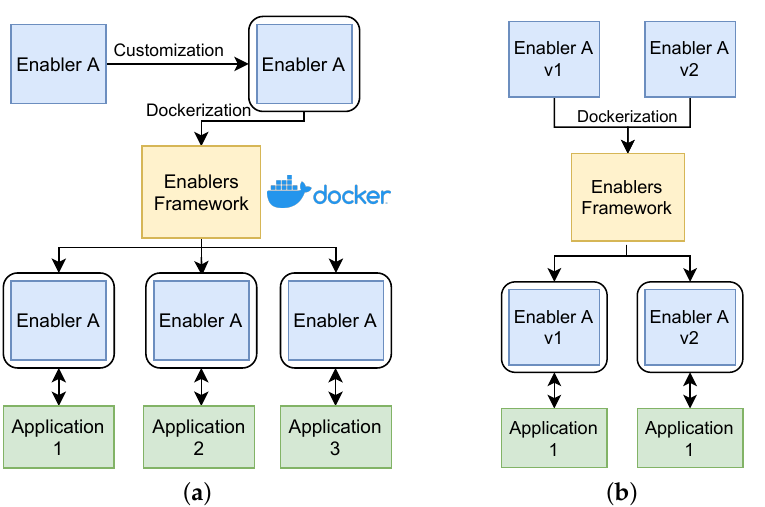
Figure 5. Dockerisation within EF: ( a ) enabler Dockerisation and replication on an IoT environment; ( b ) an application can choose the version that is